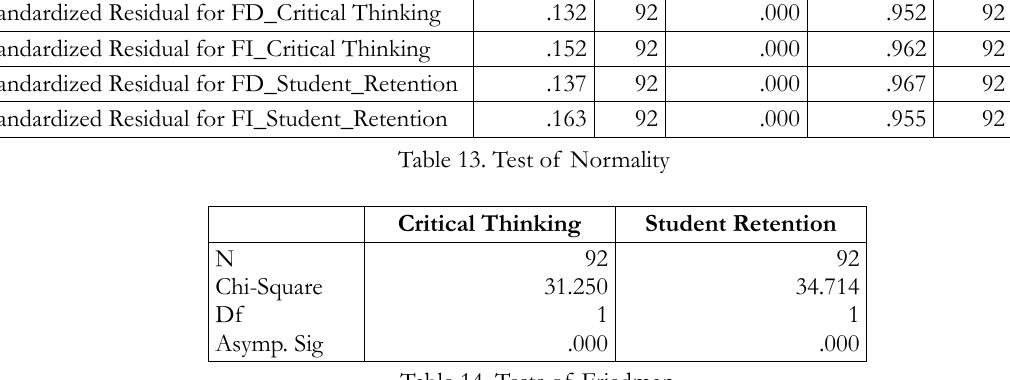
Table 14. Tests of